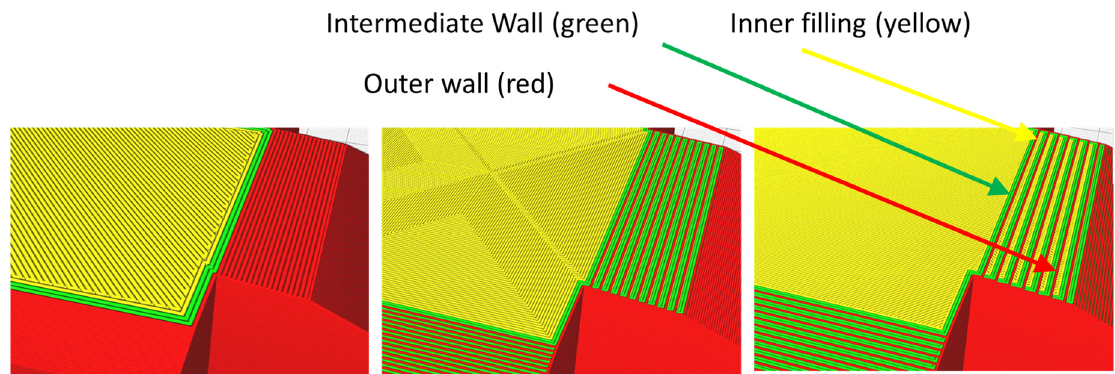
Figure 1. Examples of previous analysis. Red (outer wall), green (intermediate wall) and yellow (inner filling) layers.